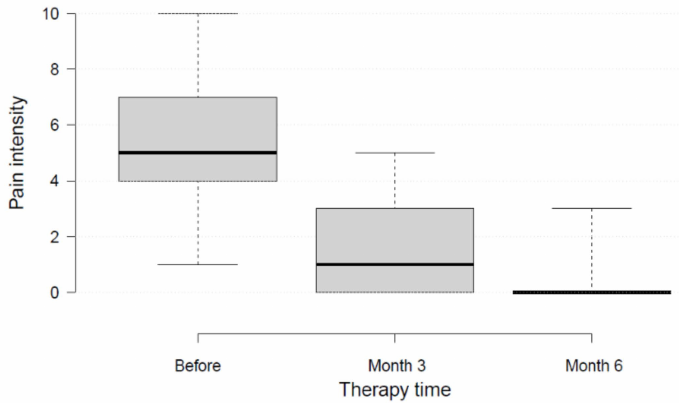
Figure 1. Pain intensity before therapy, and after three and six months of